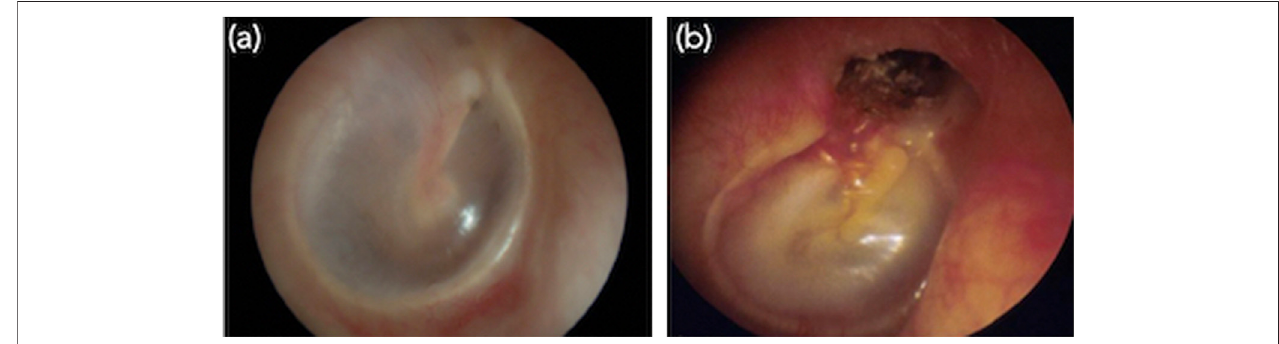
FIGURE 1 | Images of the internal of middle ear. (A) Normal ear and (B) typical primary acquired cholesteatoma, which destroyed the tympanic membrane.